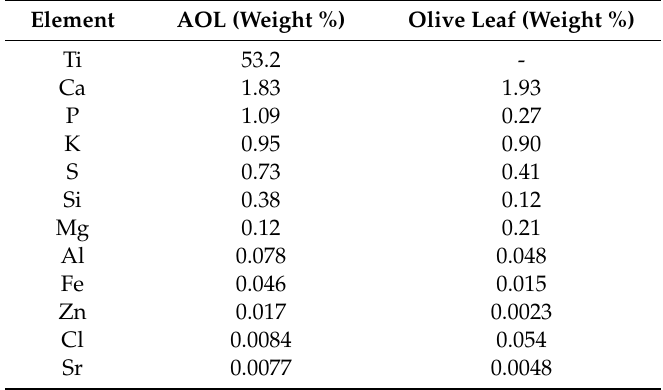
Table 1. Elemental composition of AOL as determined by XRF. For comparative purposes, composition of olive leaves [27] has also been